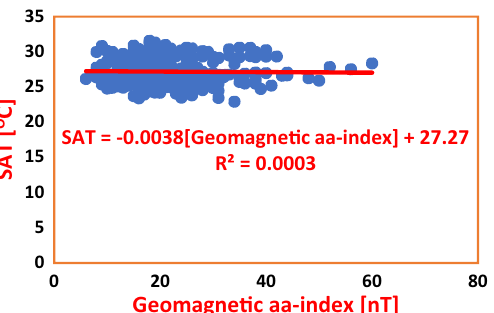
Figure 6. Regression of Geomagnetic aa-index on SAT in PHC during Solar Cycles 22–24. The Regression Equation indicates that Geomagnetic aa-index effected a decrease in SAT by 0.0038 °C. The Coefficient of Determination, R 2 shows that the impact of Geomagnetic aa-index on variability of SAT is mere 0.03%.